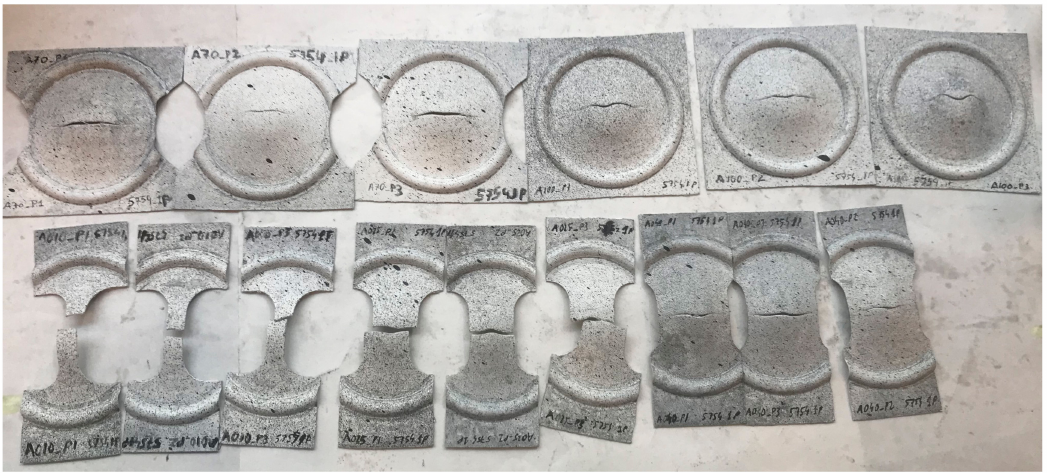
Figure 5. Fractured Nakajima samples for the sheets processed after one RCS pass.